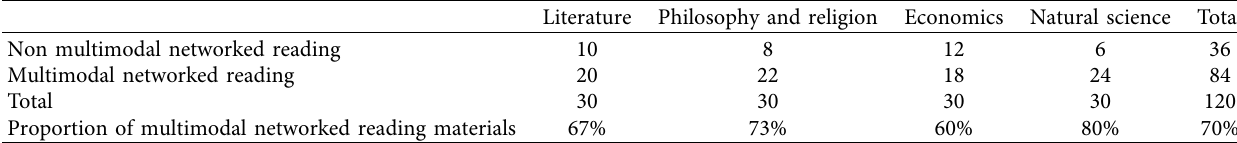
Table 1: Distribution of multimodal networked reading